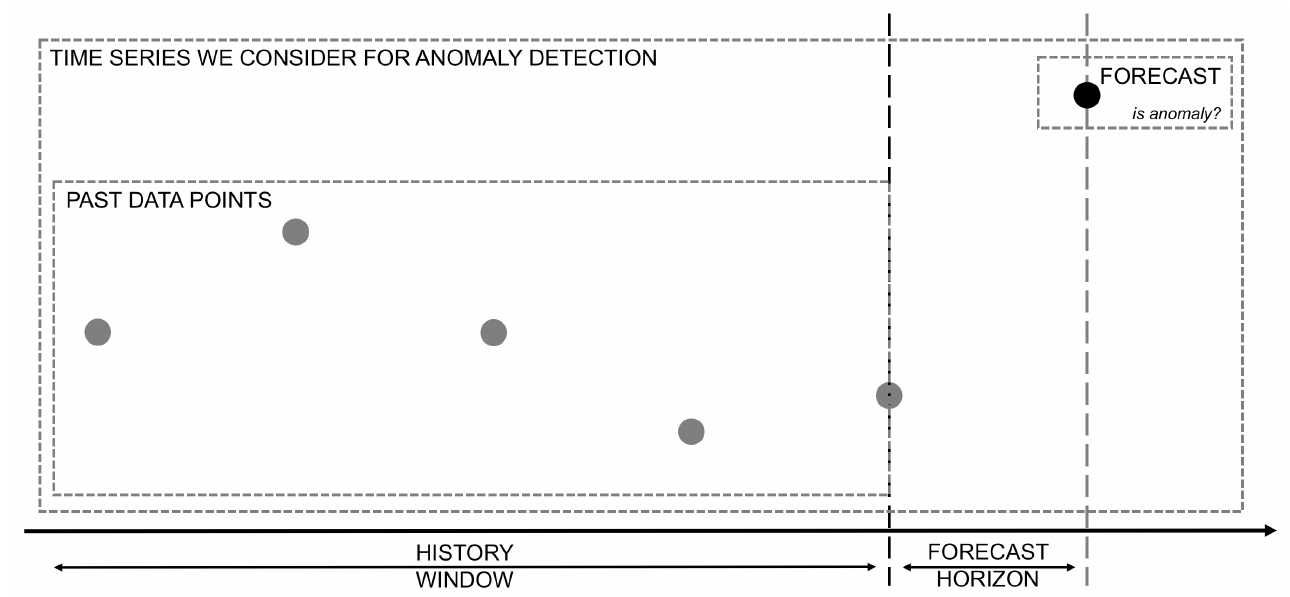
Figure 4. Diagram describing the data that we provide to build the time series context for anomaly